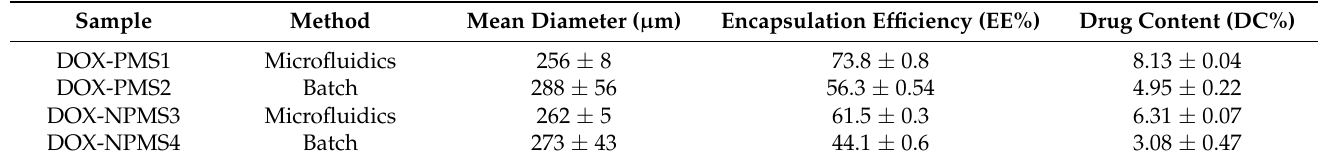
Table 1. Characterization of DOX-loaded MS fabricated via microfluidic and batch methods. Mean diameter, encapsulation efficiency (EE) and drug content are presented as mean ± standard deviation (SD; n = 3). DOX-PMS (doxorubicin porous microspheres) DOX-NPMS (doxorubicin non-porous